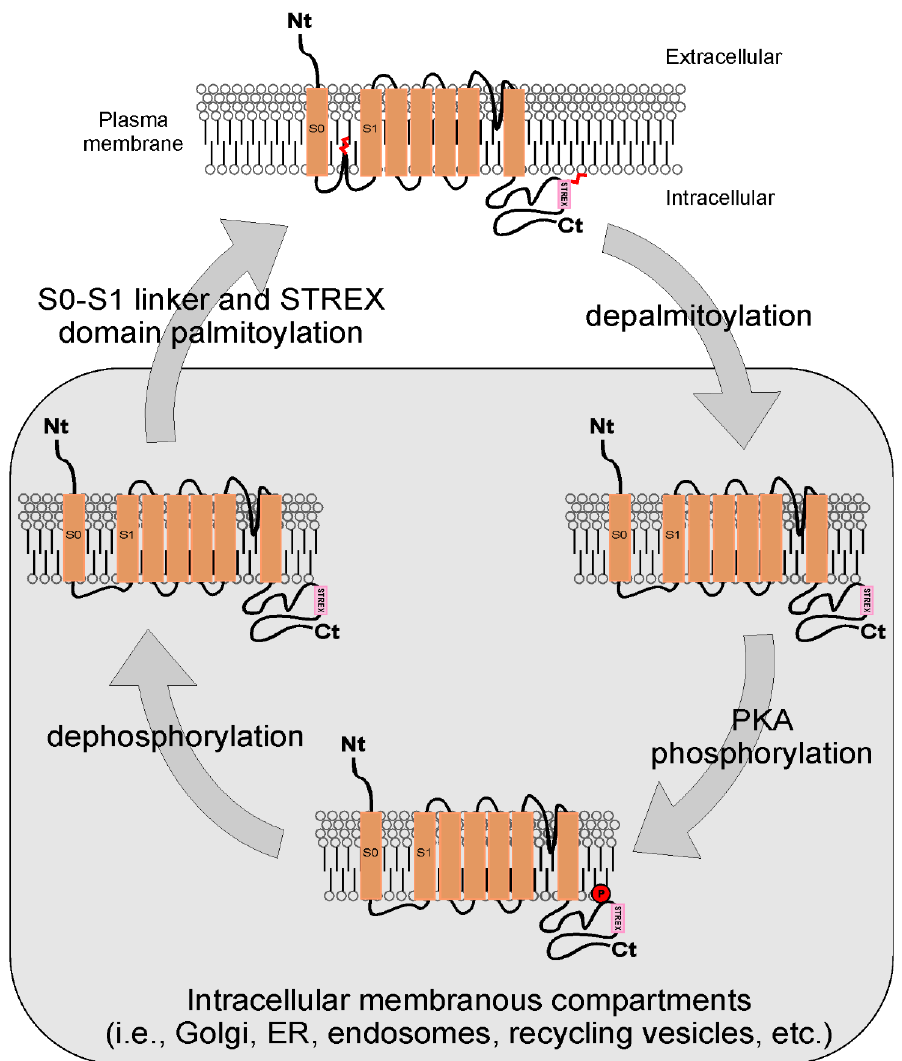
Figure 1. BK channel palmitoylation cycle. BK channels undergo S -palmitoylation on the N -terminal S0-S1 link and on the C-terminal STREX domain. The S0-S1 loop and STREX motif